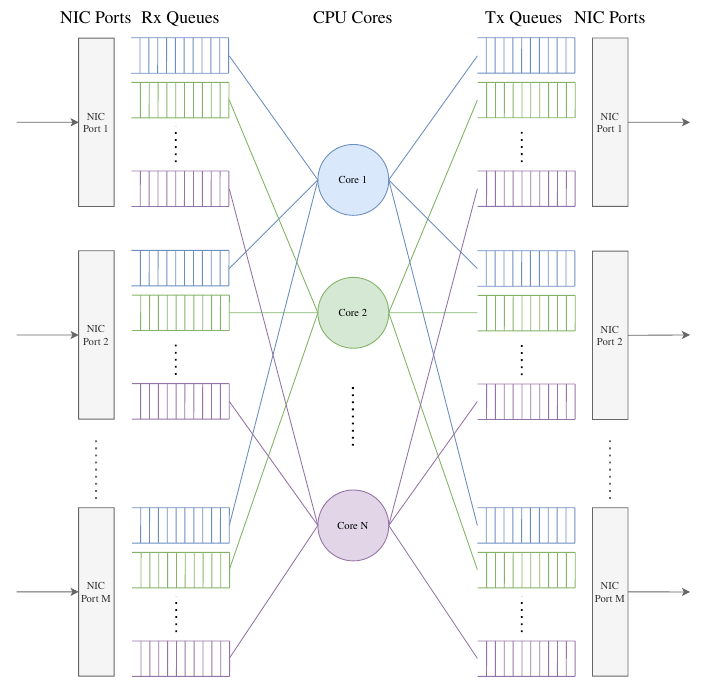
Figure 1. The basic architecture of software data